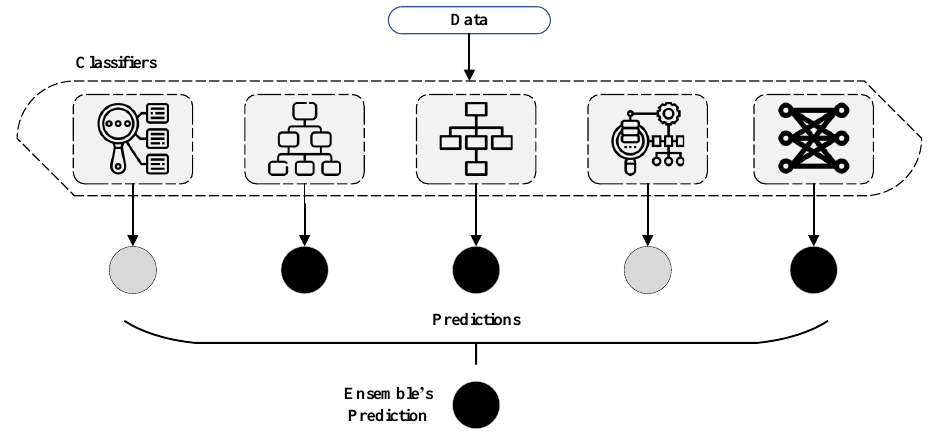
Figure 3. Ensemble learning